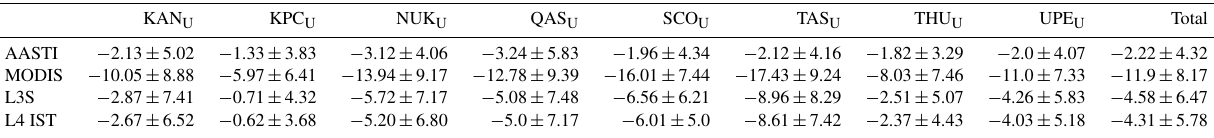
Figure 6. Time series of mean daily bias estimates (line) and their standard deviation (shaded area) for the AASTI, MODIS, L3S and L4 IST products against aggregated in situ observations from the PROMICE stations. Table 4. Mean bias and standard deviation of errors for the AASTI, MODIS, L3S and L4 IST products against in situ observations for each of the PROMICE